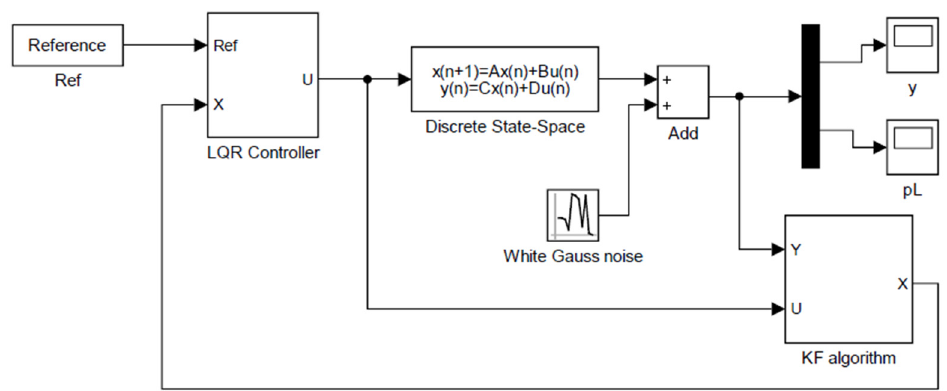
Figure 19. Simulink model of the SHA-HSD control system.